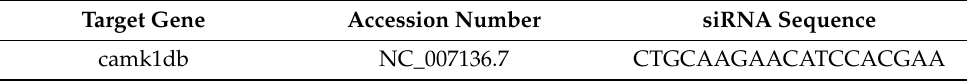
Table 1. SiRNA sequence of target genes.